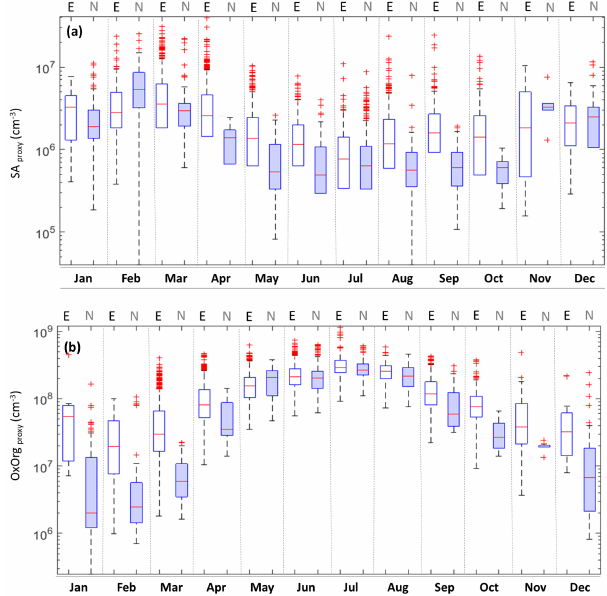
Figure 7. Monthly variation of medians and percentiles of (a) SA proxy and (b) OxOrg proxy at P >0.7 during the time window 09:00–12:00 of NPF events (E, white) and nonevents (N, shaded). See Fig. 1 for explanation of